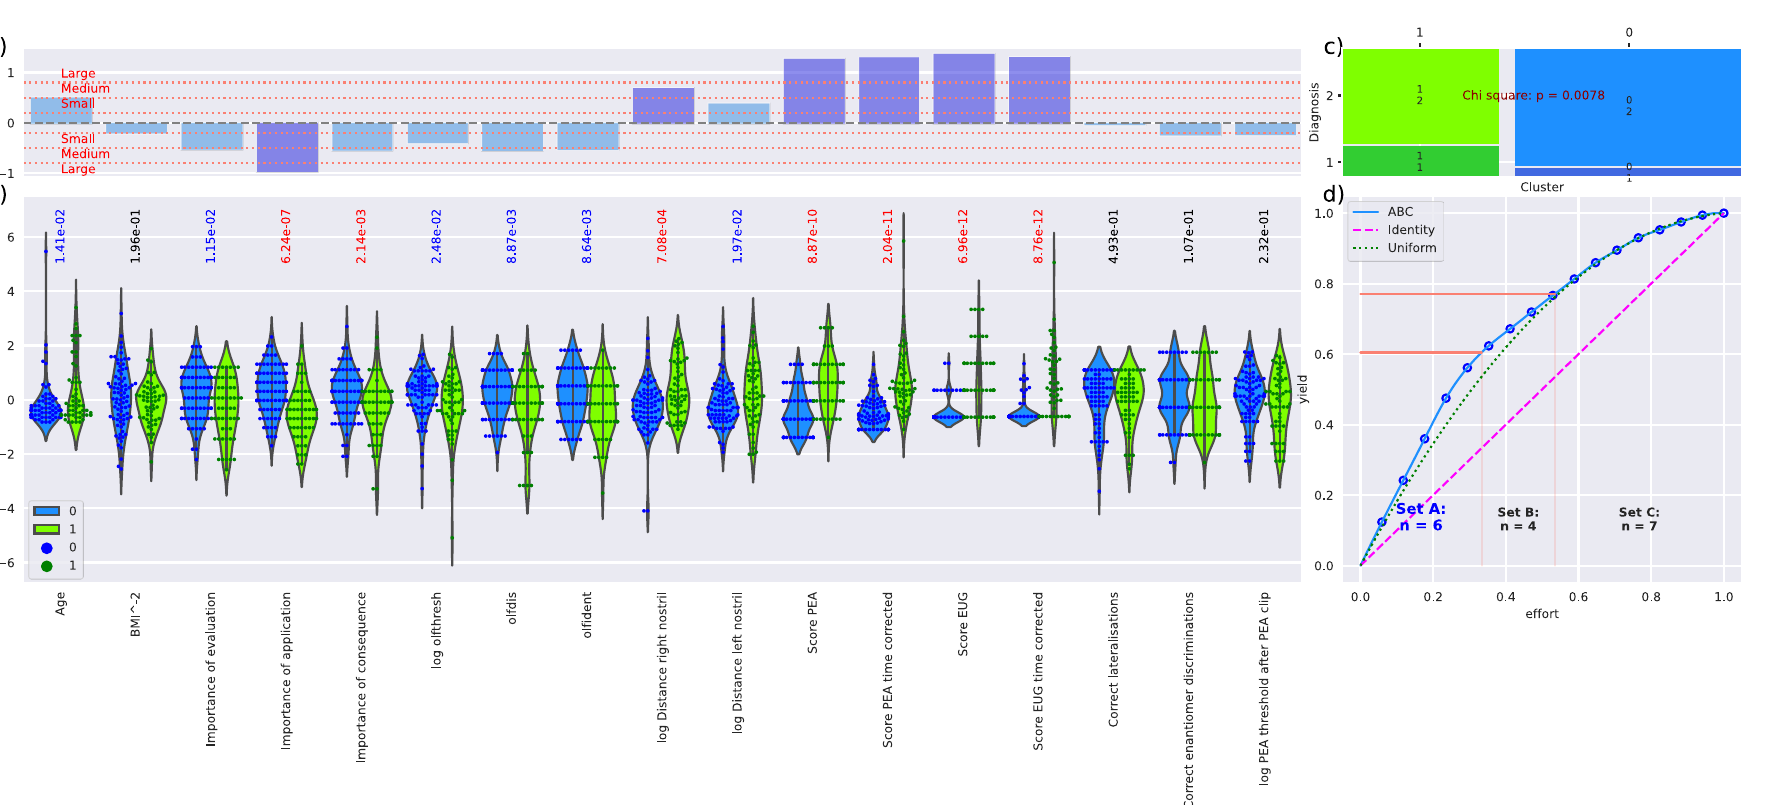
Figure 6. Differences of the d = 15 olfaction-related variables between the two k-means clusters. ( a ) Effect size calculated as Cohen’s d for the parameters used for clustering, and age and the reciprocal square transformed BMI as demographic parameters of known or possible interest of an olfactory context. The effect size of Cohen’s d > 0.2, > 0.5 or > 0.8 generally regarded as small, medium, or large effects are indicated as horizontal dotted lines. Positive values indicate larger values in cluster 1 than in cluster 0. The variables with the most relevant effect sizes according to item categorization (see panel d) are plotted in darker blue color. Variable names, if not self-explaining: “olfthresh“ = olfactory threshold to phenyl ethyl alcohol (PEA), “olfdis” = score in the odor discrimination task, “olfident” = score in the odor identification task. Higher values indicate better olfactory performance. “log Distance right/left nostril” = perception of peanut butter odor from a distance, “Score PEA/EUG” = scores in the odor sorting tasks, “Lat correct assignments overall” score in the lateralization test. Lower values indicate better olfactory performance. ( b ) Z Individual data points, z-transformed to enhance visualization of group differences across different original scales of the values, plotted as dots on violin plots showing the probability density distribution of the variables, and in addition, boxplots provide basic descriptive statistics. Statistical significance